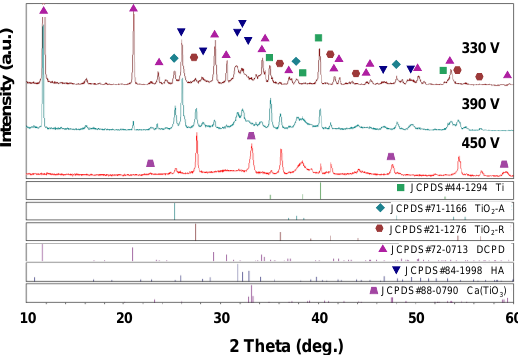
Figure 10. XRD patterns of MAO coatings prepared with different applied voltages (applied current: 0.6 A, duration time: 5 min).